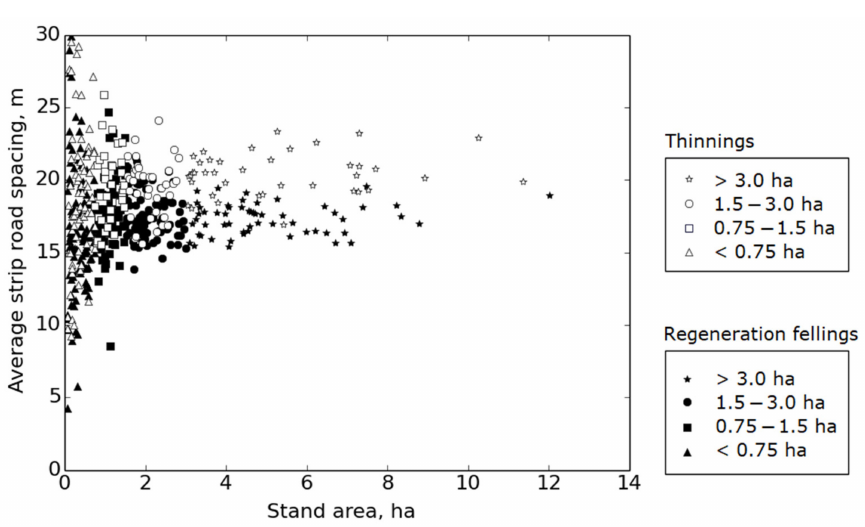
Figure 12. The stand-wise average strip road spacings shown separately for thinnings and regenera- tion fellings in different stand area